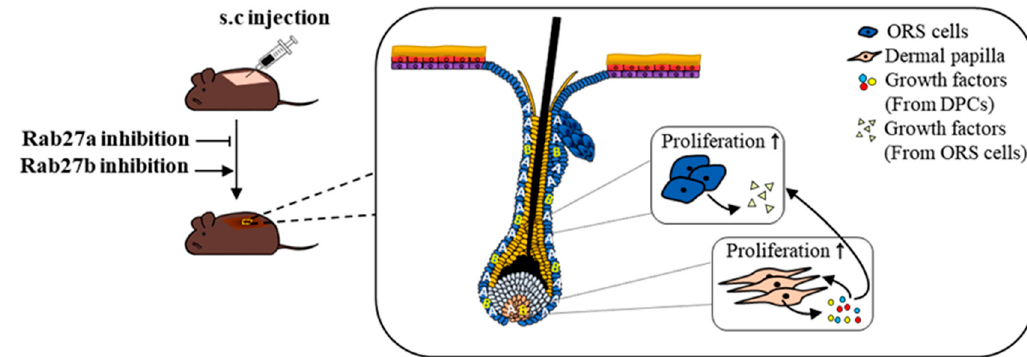
Figure 7. Scheme for regulating hair growth of Rab27a and Rab27b. Rab27a and Rab27b were mainly distributed in ORS cells of HFs. Rab27b inhibition stimulated ORS cells and DPCs and increased the expression of multiple growth factors.